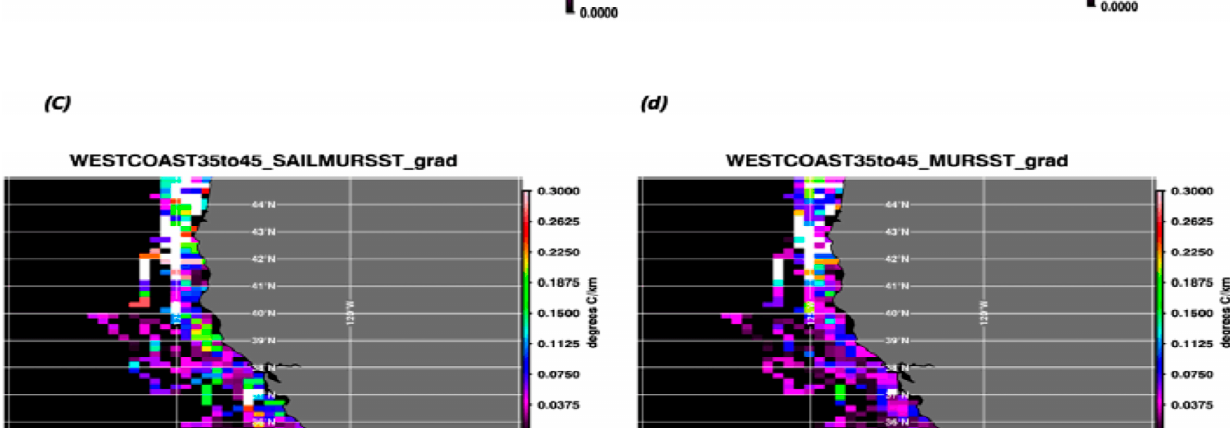
to 42°N. This is visible in both the JPLSSS and SAILSSS. The spatial extent of the high gradients appears greater in the JPLSSS product.